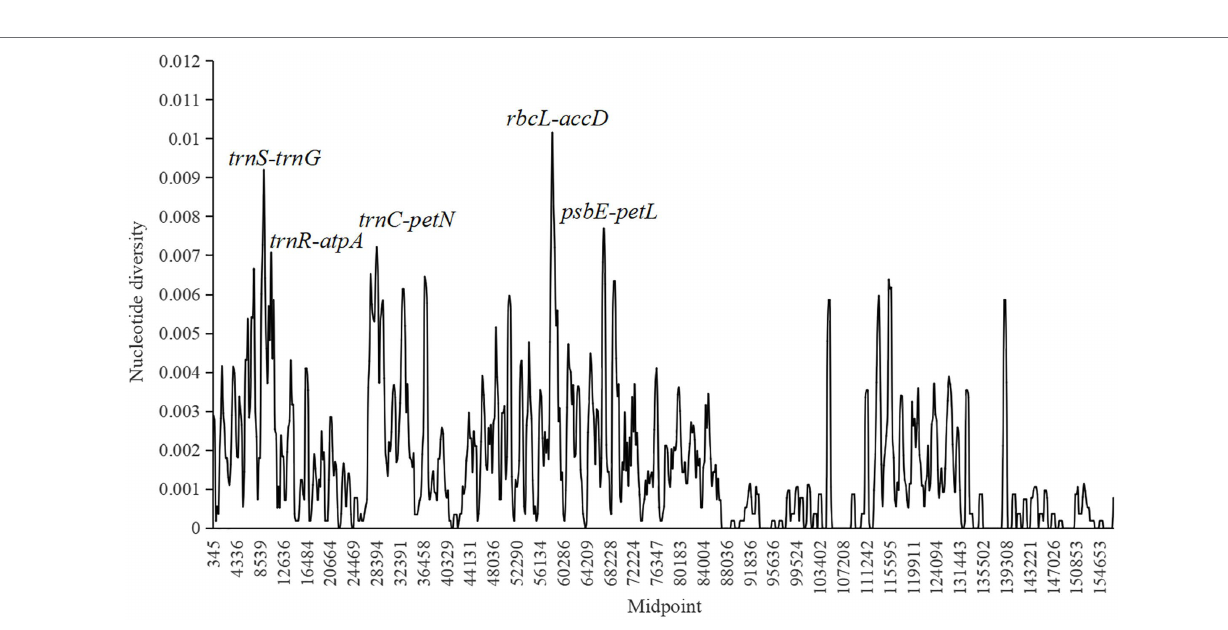
FIGURE 4 | Sliding window analysis of 18 complete chloroplast (cp) genomes of Fragaria species (window length, 600 bp; step size, 200 bp; x -axis, position of the midpoint of a window; y -axis, nucleotide diversity of each window). Each highly polymorphic region of the Fragaria cp genomes is annotated on the graph.